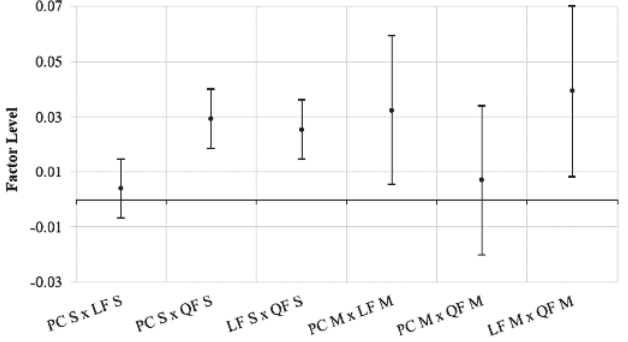
Comparative analysis of the averages, Tukey's test, for 20 weeks of exposure among the series studied, for a significance level of 5% (S-sodium sulfate and M-Magnesium